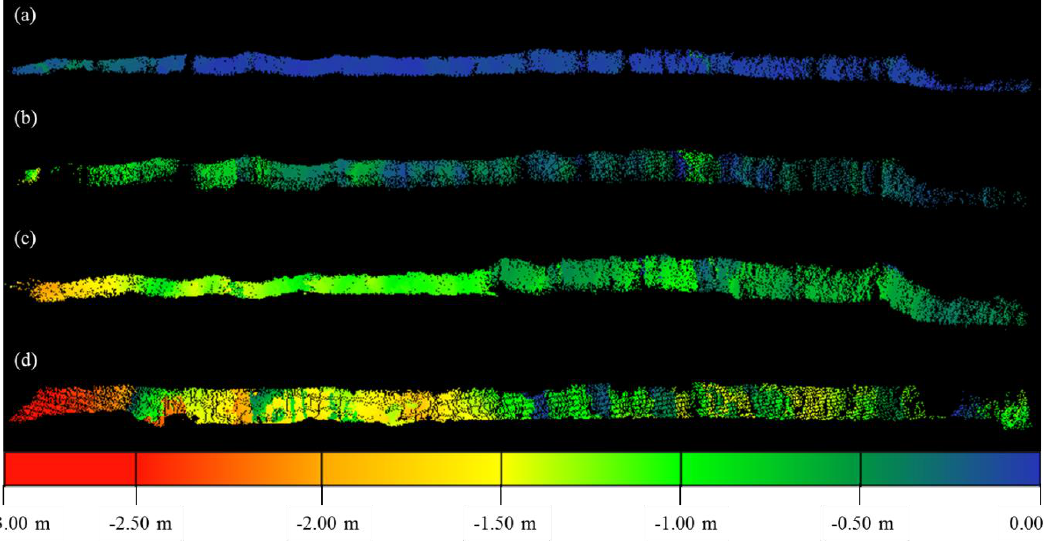
Figure 5. Multi-Model to Model Cloud Comparison (M3C2) change analysis results for a ) interval 1, b ) interval 2, c ) interval 3, and d ) interval